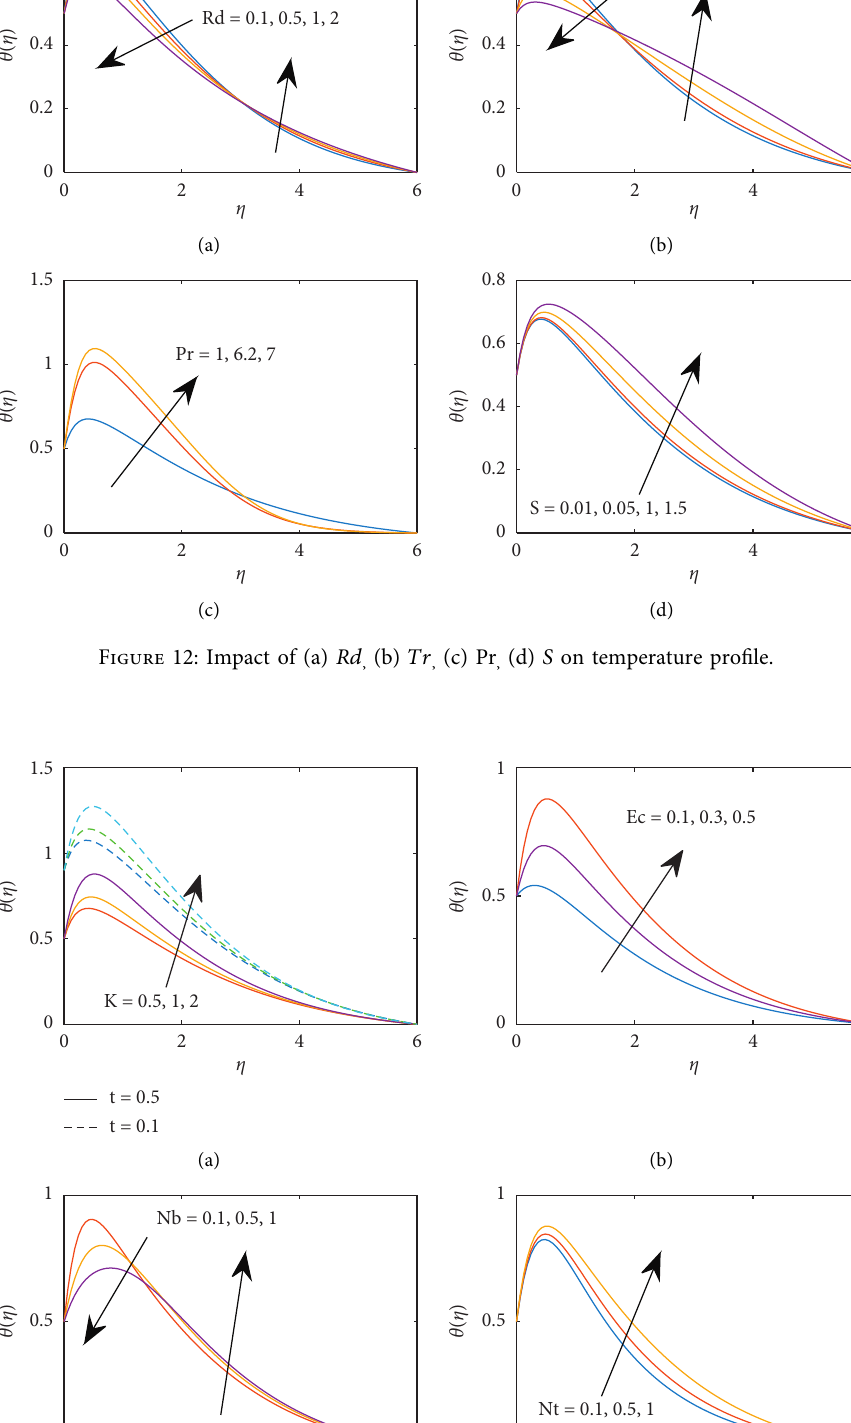
Ec Nb Nt on temperature , (b) , (c) , (d)